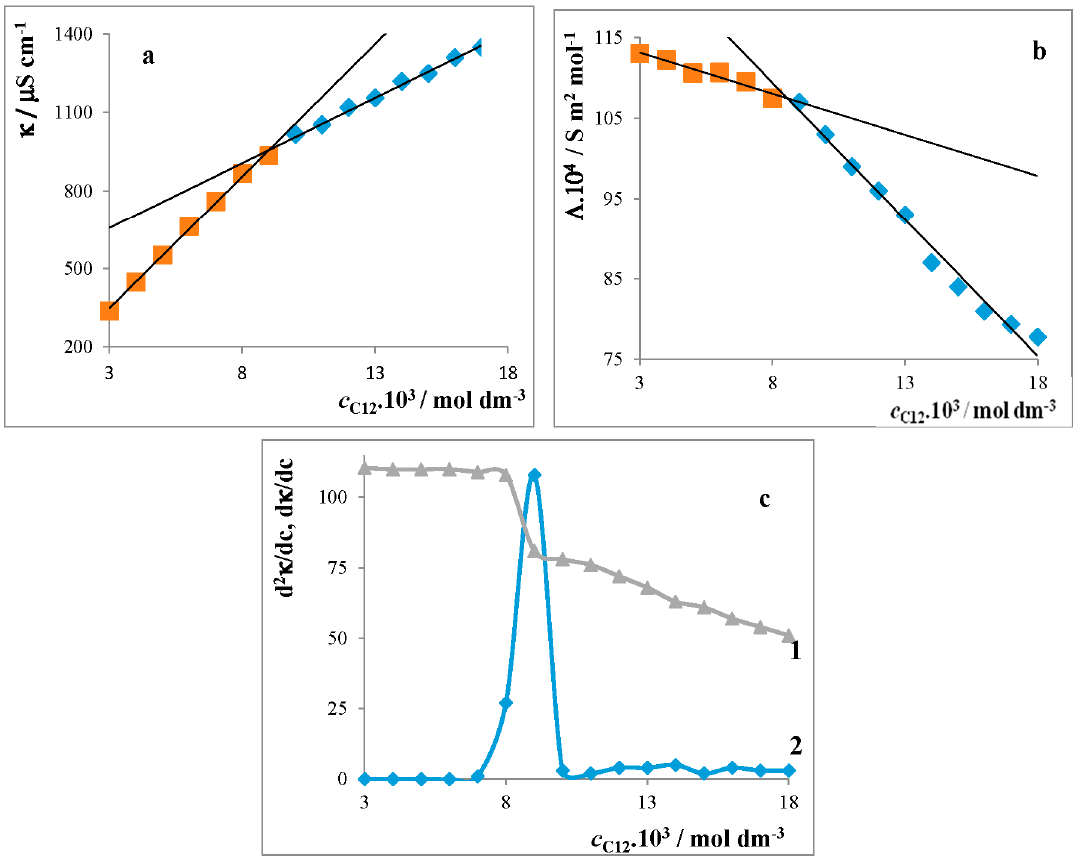
Figure 1. Dependence ( a ) κ = f ( c C12 ); ( b ) Λ = f ( c C12 ); and ( c ) curve 1 : d κ /dc = f ( c C12 ) and curve 2 : d 2 κ /dc = f ( c C12 ) for surfactant C12 at the temperature 30 °C.